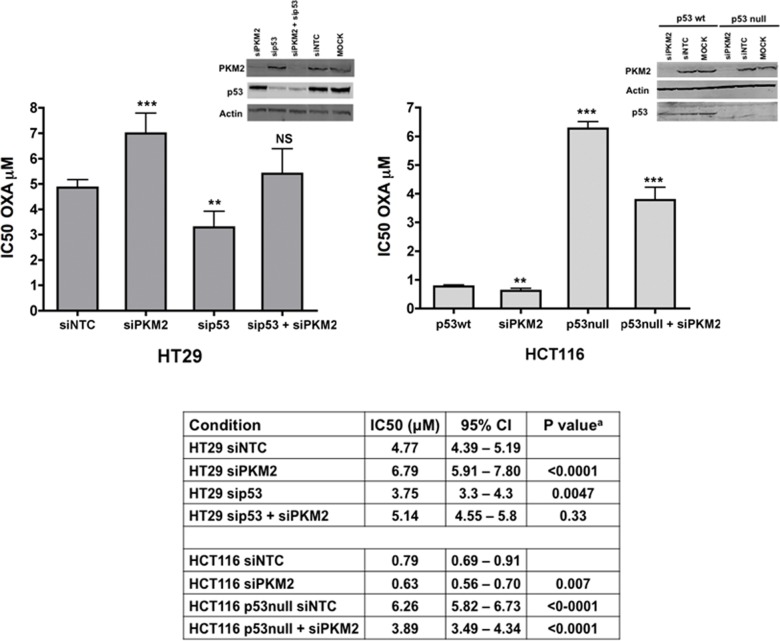
Effect of PKM2 silencing according to p53 in HT29 and HCT116 cell lines.Bars represent the IC50 ± SD (average values from at least three independent experiments) for oxaliplatin for each condition. Insets show PKM2 and p53 inmunoblotting after PKM2 gene silencing. Specific IC50 values for oxaliplatin in all conditions are displayed in the table. IC50 values for Mock conditions (without transfection) were very similar to those of siNTC and are not shown. *p-values are result of comparison to the siNTC condition. * P- value < 0.05. ** P-value < 0.01; *** P-value < 0.001